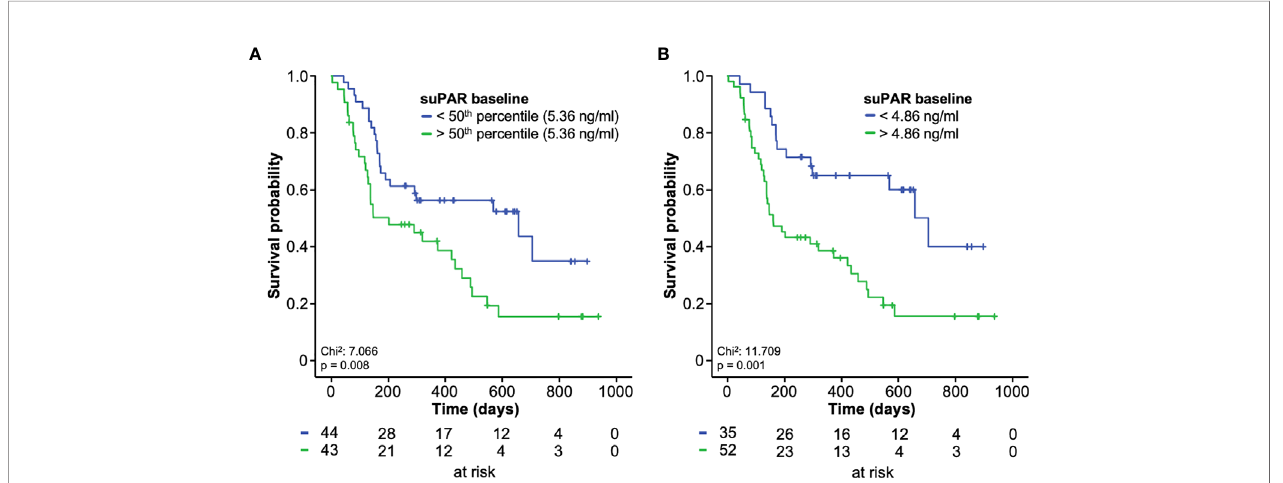
FIGURE 3 | Baseline suPAR levels predict overall survival in patients receiving ICI. (A) Using the median suPAR concentration (5.36 ng/ml) as a cut-off, patients with initial suPAR levels above this cut-off show a signi fi cantly reduced OS compared to patients with low baseline suPAR levels. (B) When applying the optimal cut-off value (4.86 ng/ml), patients with a baseline suPAR concentration >4.86 ng/ml have a median OS of just 160 days compared to 705 days for patients with initial suPAR concentrations below the ideal cut-off.